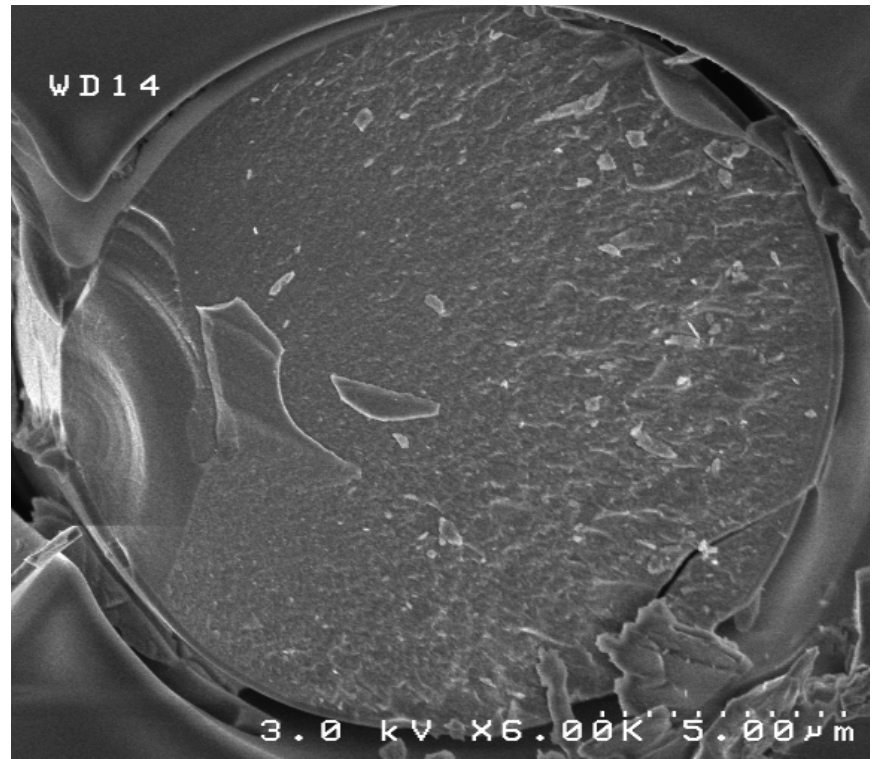
Figure 10. Typical facies of slow crack growth.